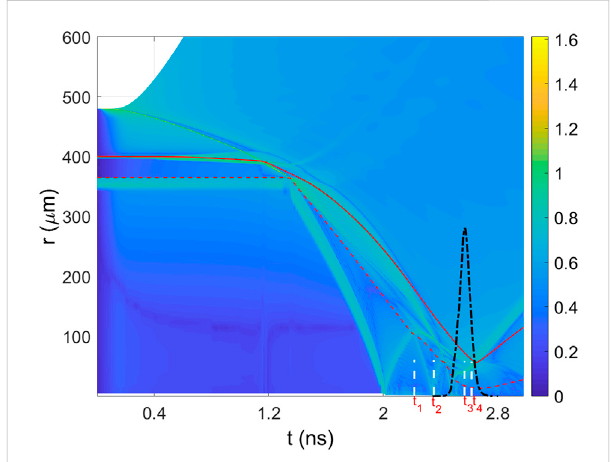
FIGURE 1 Evolution of the hydrodynamic fronts represented by the fl uid velocitygradient( | ∇ u | )foranindirect-driveimplosionsimulatedbythe RH code RDMG. The black dash-dotted line represents the neutron yield at the Bangtime (arb. unit). The red solid and dashed lines represent the ablator surface and ice-gas interface, respectively. t 1 , t 2 , t 3 , t 4 represent thebeginning ofdeceleration stage (t = 2.22 ns), shock convergence time (second), Bangtime (t = 2.57 ns), and stagnation time (t = 2.63 ns),